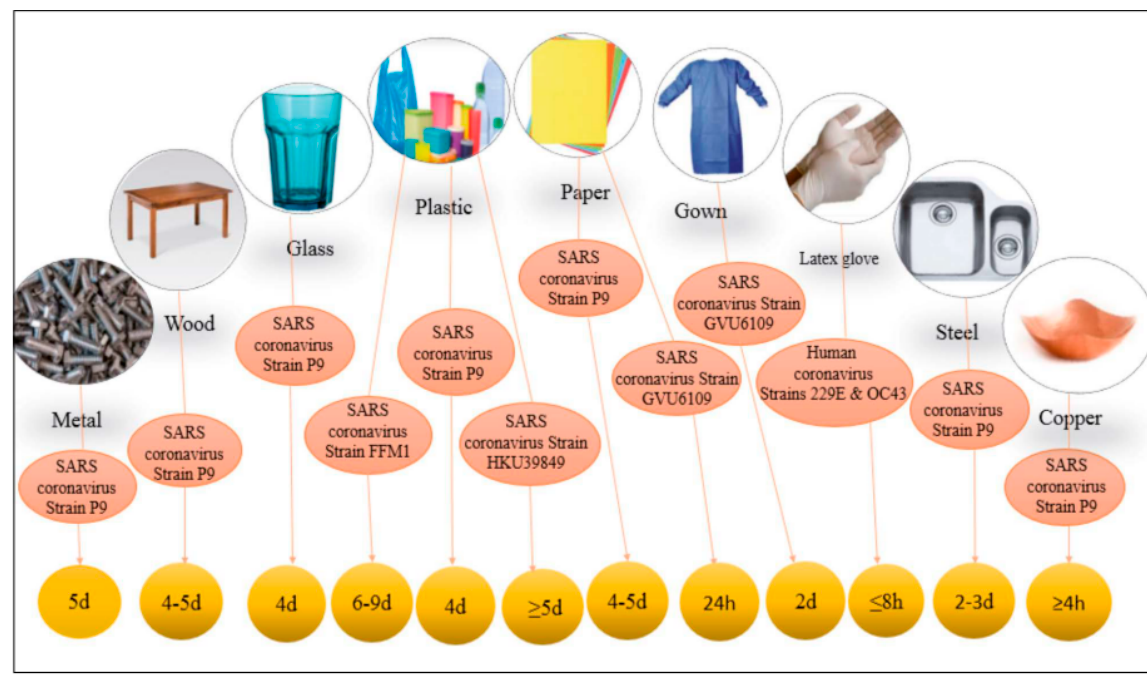
Figure 4. Survival of SARS-CoV-2 on different surfaces [73].